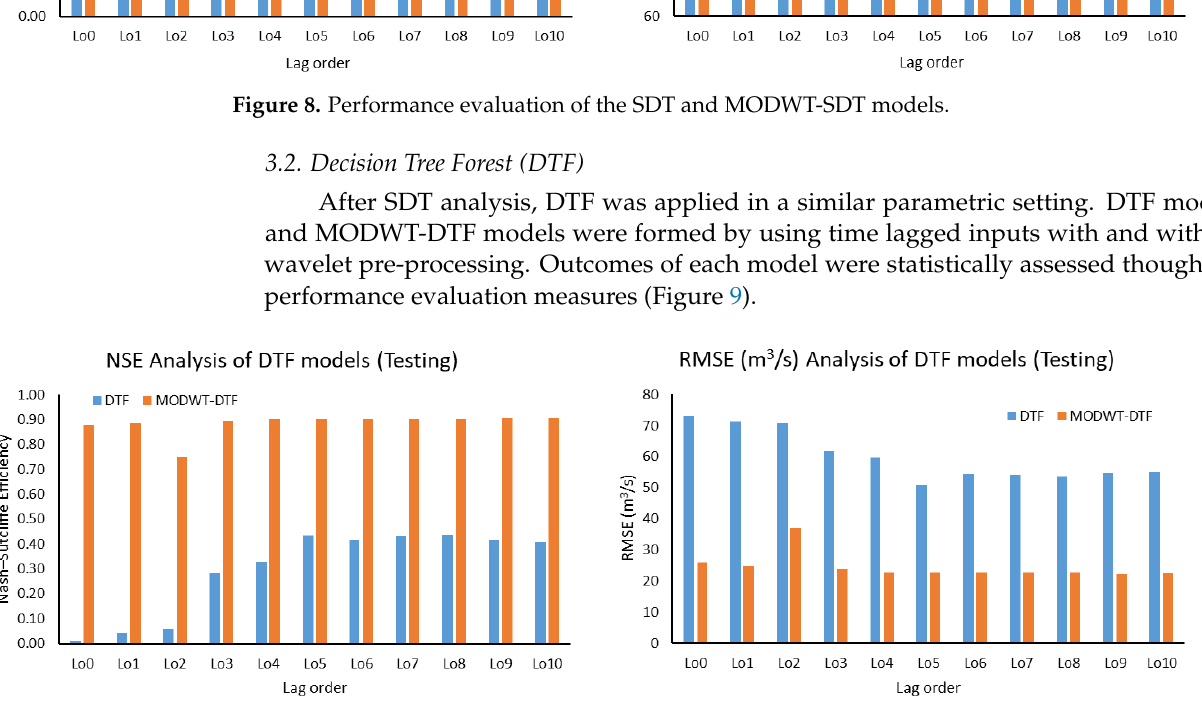
Figure 9. Performance evaluation of the DTF and MODWT-DTF models.